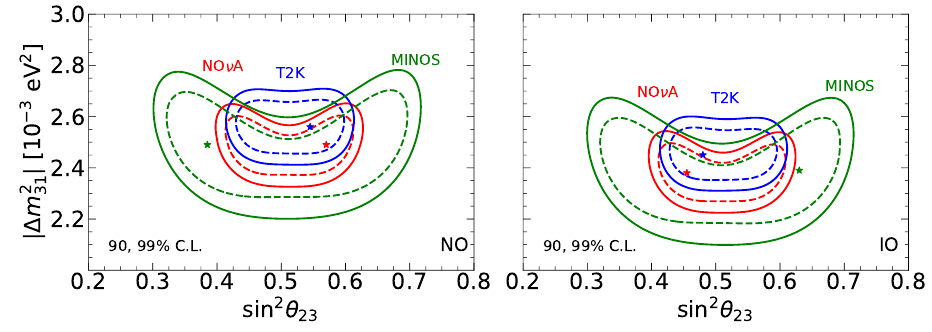
plane for NO (left) and 31